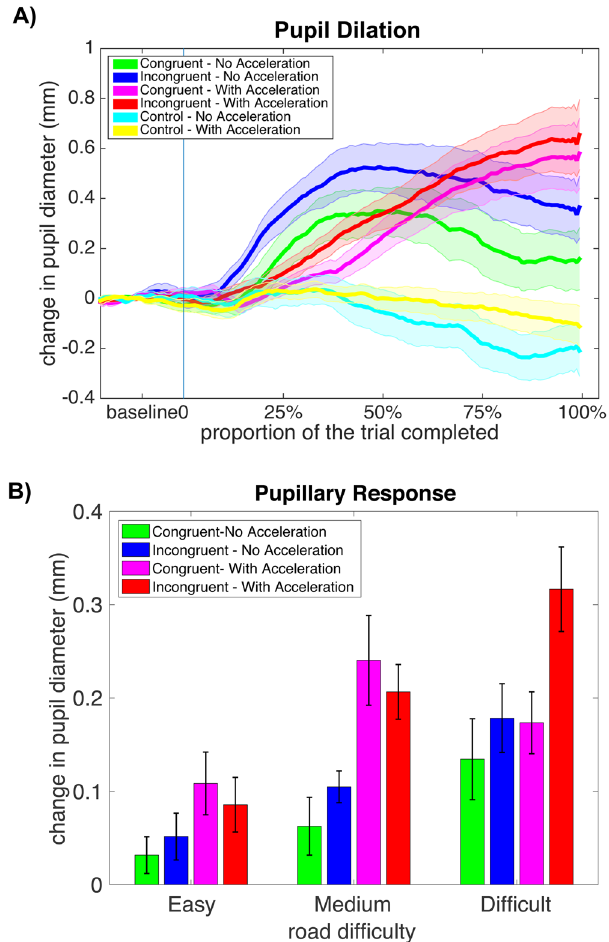
Figure 2. Pupillary responses. ( A ) The shaded lines show mean (standard error) of the changes in pupil diameter (relative to baseline) over the course of the trial across different conditions. Green (pink) lines indicate congruent steering with (w/o) acceleration, blue (red) lines indicate incongruent steering with (w/o) acceleration, and cyan (yellow) lines indicate control trials with (w/o) acceleration. ( B ) Mean (standard error) of changes in pupil diameter across different conditions. The green (pink) bars indicate congruent steering with (w/o) acceleration and blue (red) bars indicate incongruent steering with (w/o)